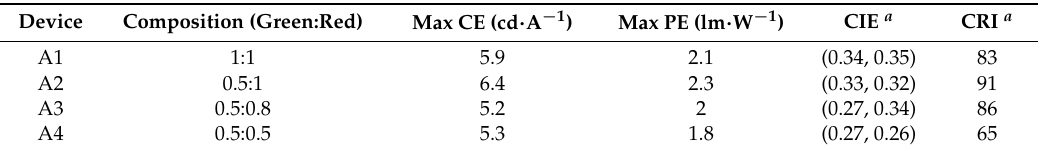
Table 1. Performance for white polymer light-emitting devices (WPLEDs) with polymers P1, P2, P3 and P4 as white-light emitters, respectively.